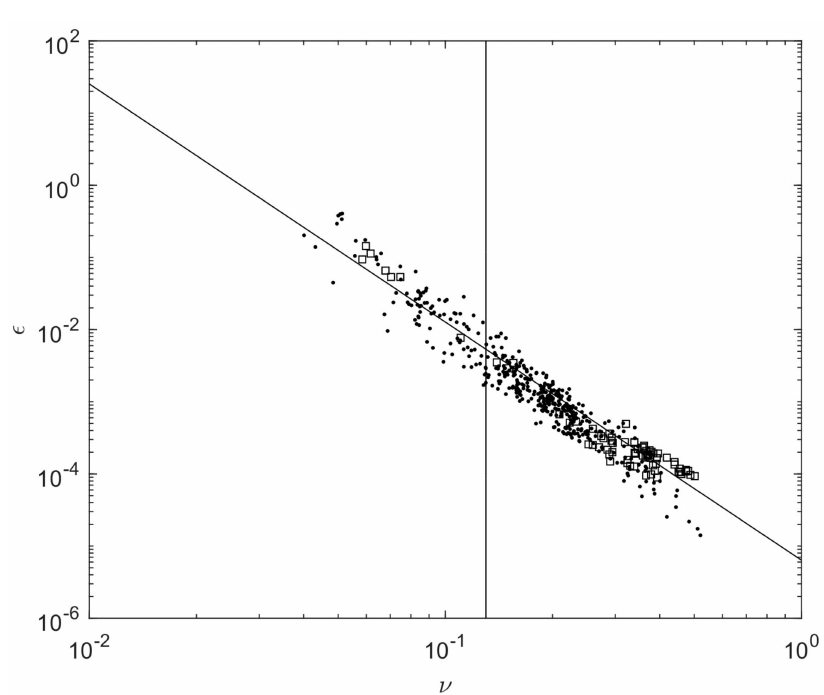
Figure 3. Values of the non-dimensional energy, ε as a function of non-dimensional peak frequency, ν . The buoy data of Young [30,31] are shown by the solid dots and the aircraft based Hurricane Hunter data [48–51] by the open squares. The vertical line makes the commonly adopted division between swell (left of line) and wind-sea (right of